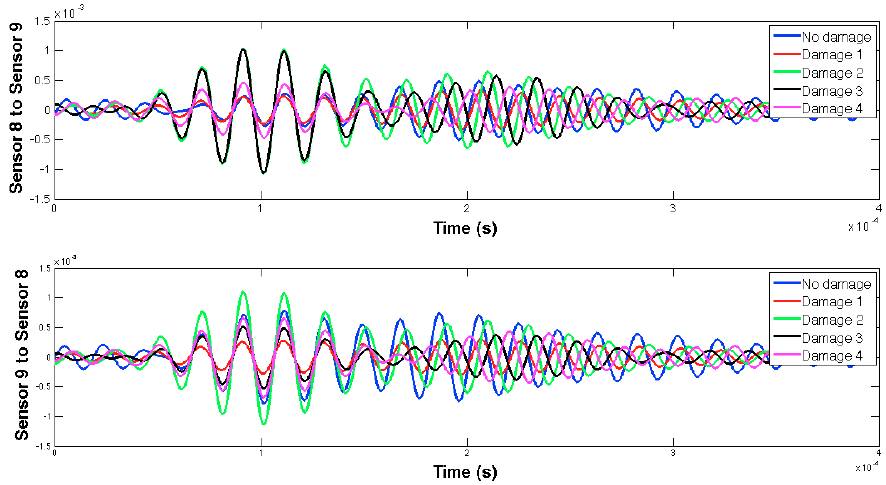
Figure 27. EMPD at 50 kHz. Tone-burst sent and measured between sensors 9 and 10. Each of the graphics shown in Figure 20 demonstrates the presence of the series of damage stages generated in the RC strengthened beam, and it is even possible to discriminate which one could have a higher impact on each sensing region. However, this is just a qualitative analysis of a